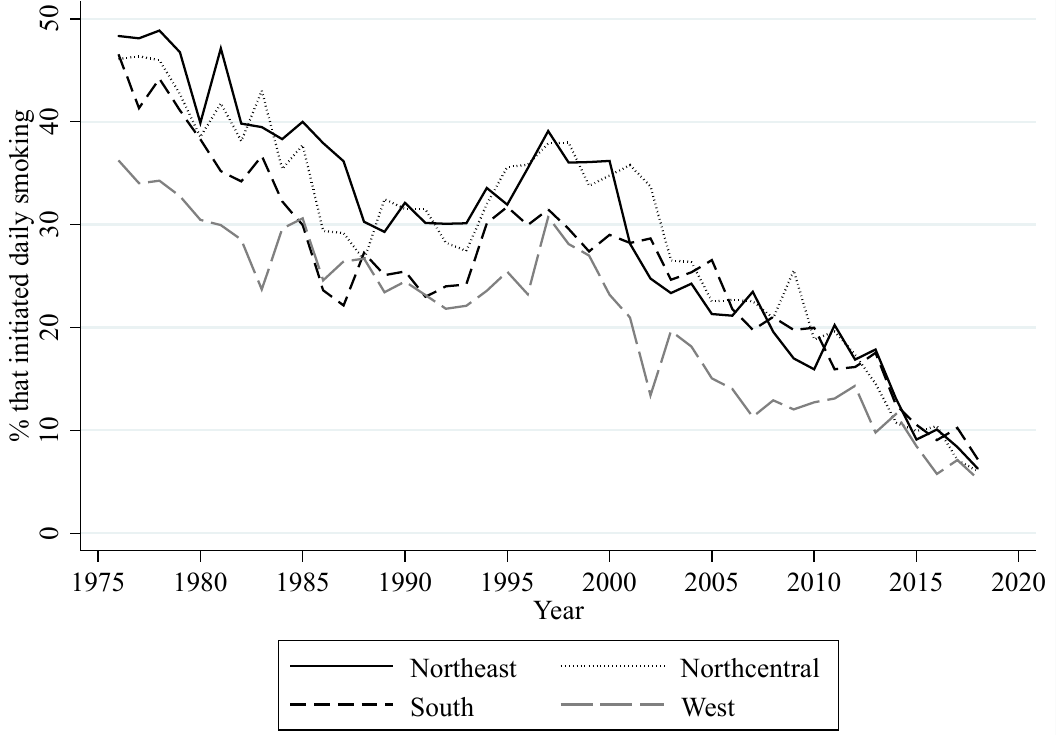
Figure 4. Annual percentage of U.S. high school seniors that have started daily smoking.